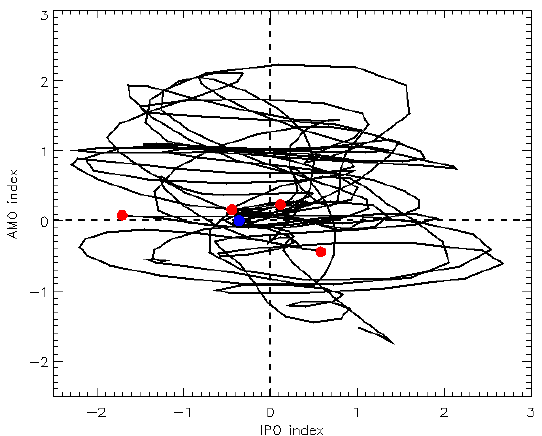
Fig. 21. HadGEM2-ES control run evolution in AMO/IPO phase space. Red dots show 50-yr intervals used for four existing HadGEM2-ES historical ensemble members. The blue dot shows the mean position of these four initial conditions.